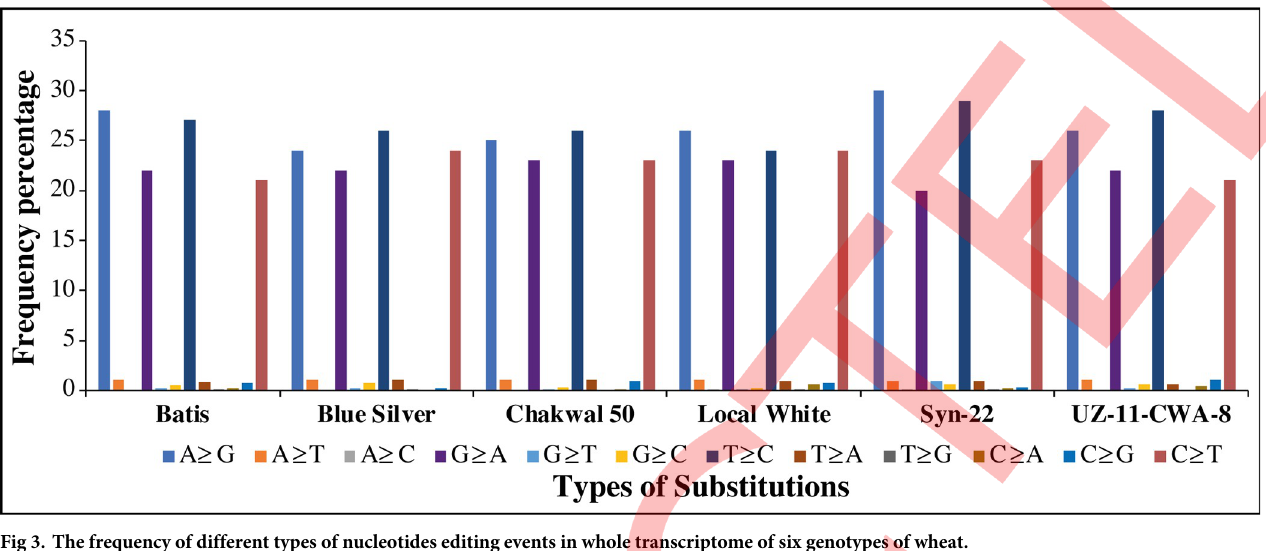
Fig 3. The frequency of different types of nucleotides editing events in whole transcriptome of six genotypes of wheat.